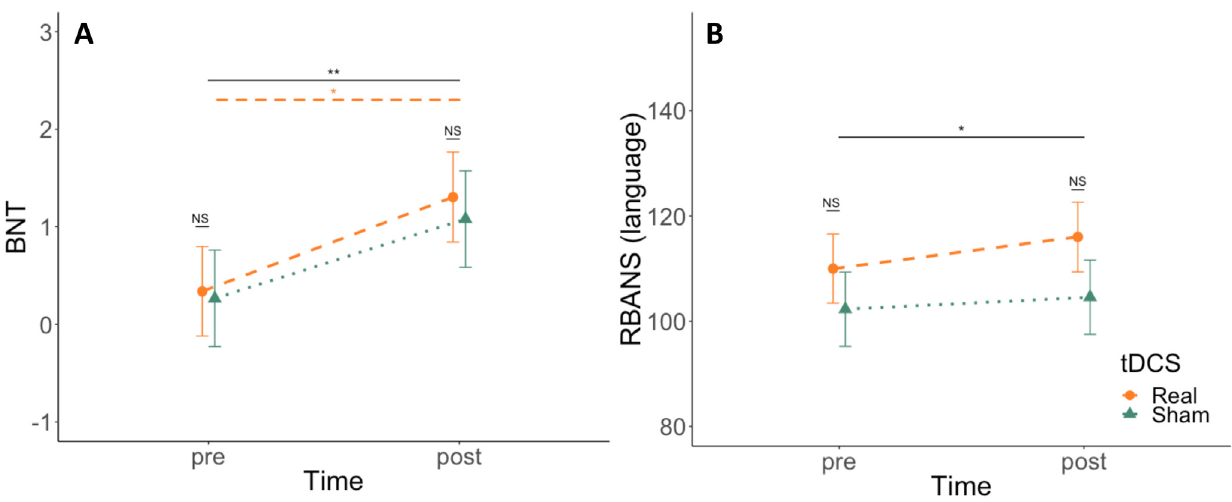
Figure 8. Mean pre- and postscores for the phonological loop on the A . Boston Naming Test (BNT), and B . RBANS Language index for the sham (dotted, triangles) and real (dashed, circles) group with 95% confidence intervals. Continuous lines indicate main effects, dashed and dotted lines indicate a significant difference between the pre- and postscores of the separate group (real: dashed; sham: dotted) as found by the post-hoc analyses. NS = non-significant; * = p ≤ 0.05; ** = p ≤ 0.01.